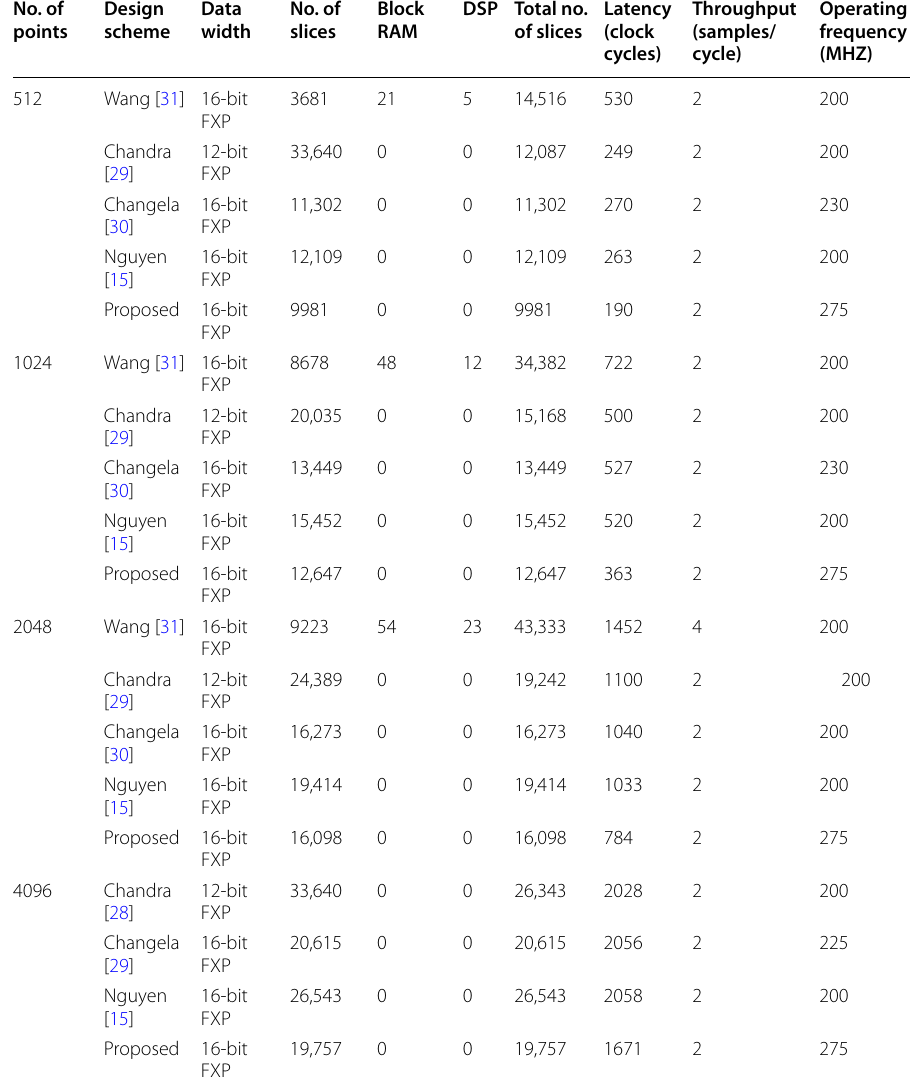
Table 2 The proposed architecture is compared with the implemented architecture No. of